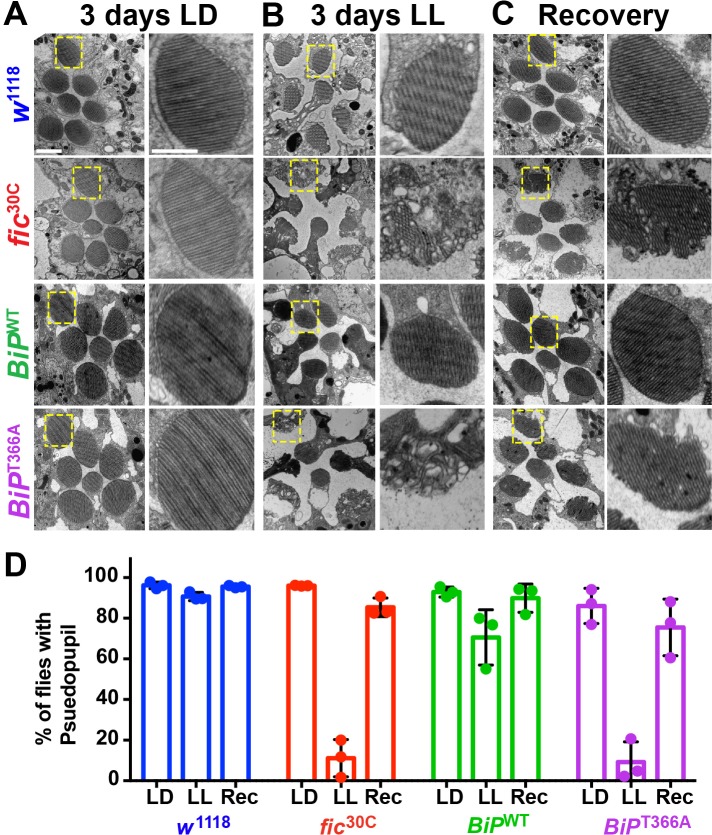
AMPylation of BiP is required for maintaining structural plasticity in the retina.(A–C) Representative TEM images of retina thin sections from the indicated genotypes with either standard LD (A), the stress-inducing LL (B) or recovery treatment (C). Scale bars: 1 µM. Yellow boxes indicate rhabdomeres shown in high magnification images. High magnification scale bars: 0.5 µM. (D) Percentages of flies with intact deep pseudopupil following LD, LL and Rec. N = 3 independent biological replicas with approximately 50 flies scored per genotype per replica. Bar graphs show means ± SD.10.7554/eLife.38752.020Figure 4—source data 1.Relates to Figure 4D.Scoring of flies for deep pseudopupil defects.